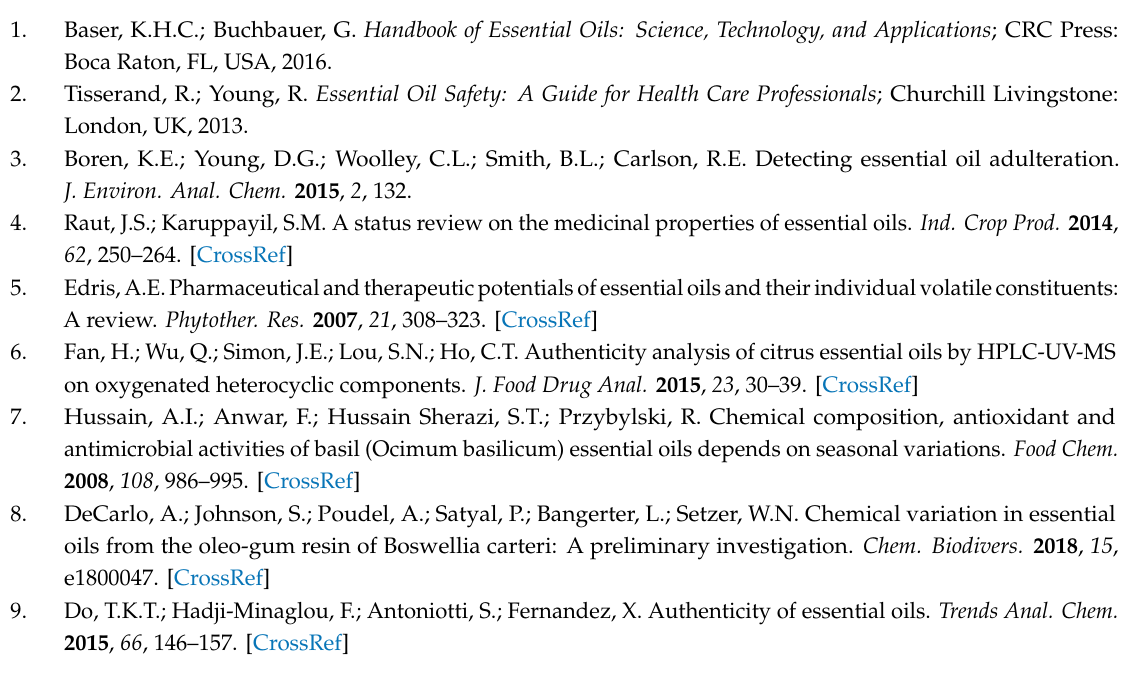
oil CC3a; Figure S16, copaiba essential oil CC3b; Table S1, summary of GC-MS data for mandarin essential oils; Table S2, summary of GC-MS data for turmeric essential oils; Table S3, summary of GC-MS data for Melissa essential oils; Table S4, summary of GC-MS data for copaiba essential oils; Table S5, list of primary antibodies; Table S6, assignment of pI values to protein